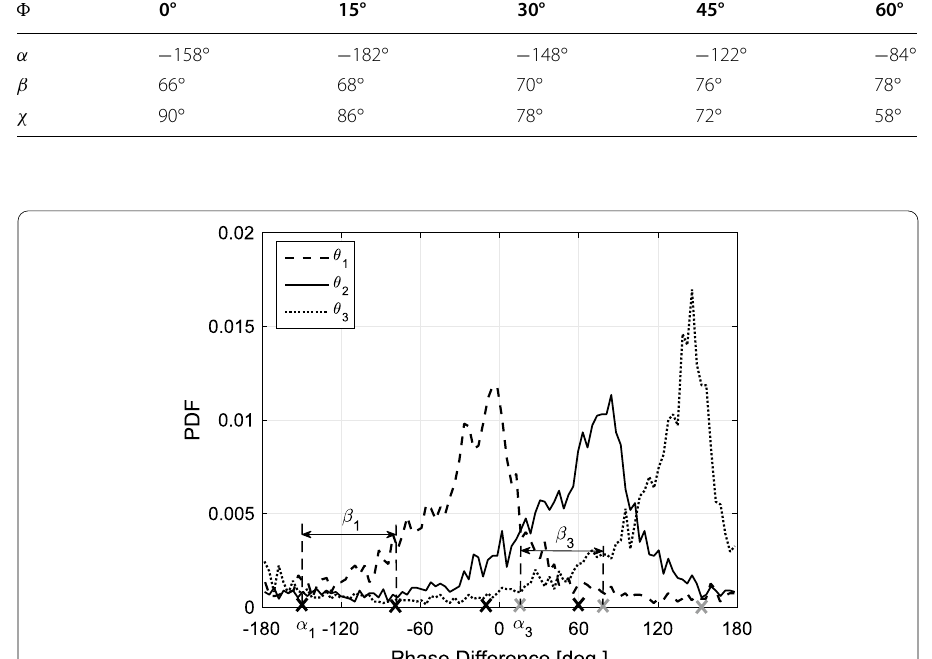
Fig. 8 Parametric codebook design for the UCA using multiple parameter pairs (α k , β k